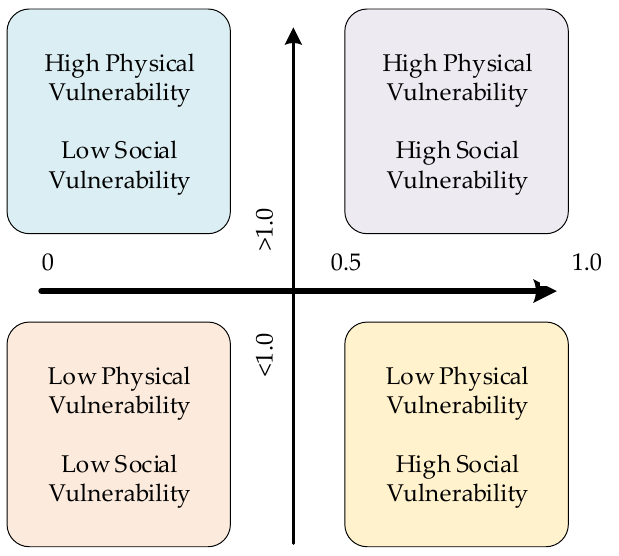
Figure 3. Four-quadrant conceptual frame for environmental health vulnerability assessment.